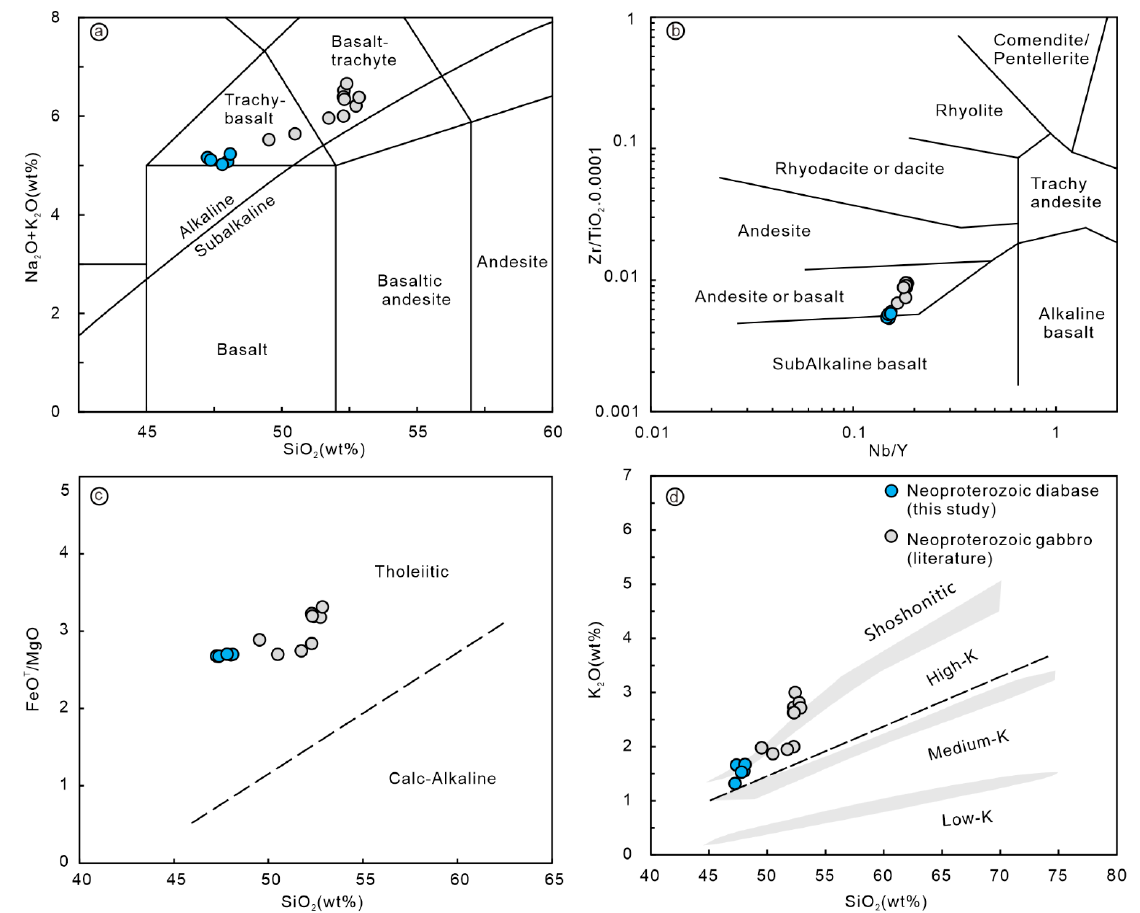
Figure 5. Rock classification diagrams. ( a ) Total alkali versus silica (TAS) diagram (from [54]). ( b ) Nb/Y versus Zr/Ti diagram (modified from [55]). ( c ) SiO 2 versus FeO T /MgO plot [56]. ( d ) K 2 O versus silica diagram [57]. Data sources: Neoproterozoic gabbro [27,45]. Data can be found in Supplementary Table S1.